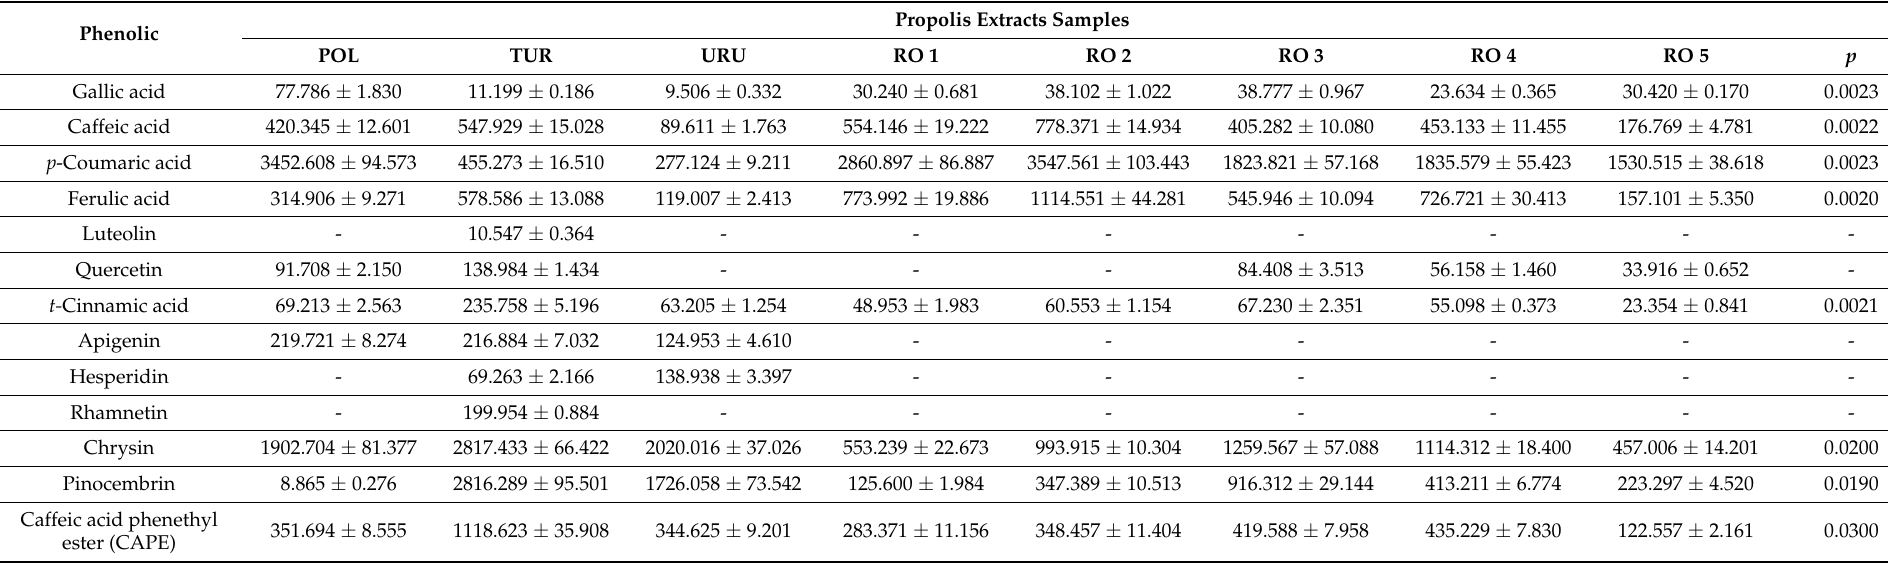
Table 2. Phenolic compounds detected in propolis extracts [ µ g/g dry weight, n = 3, ± SD, p -level of statistical significance] by HPLC